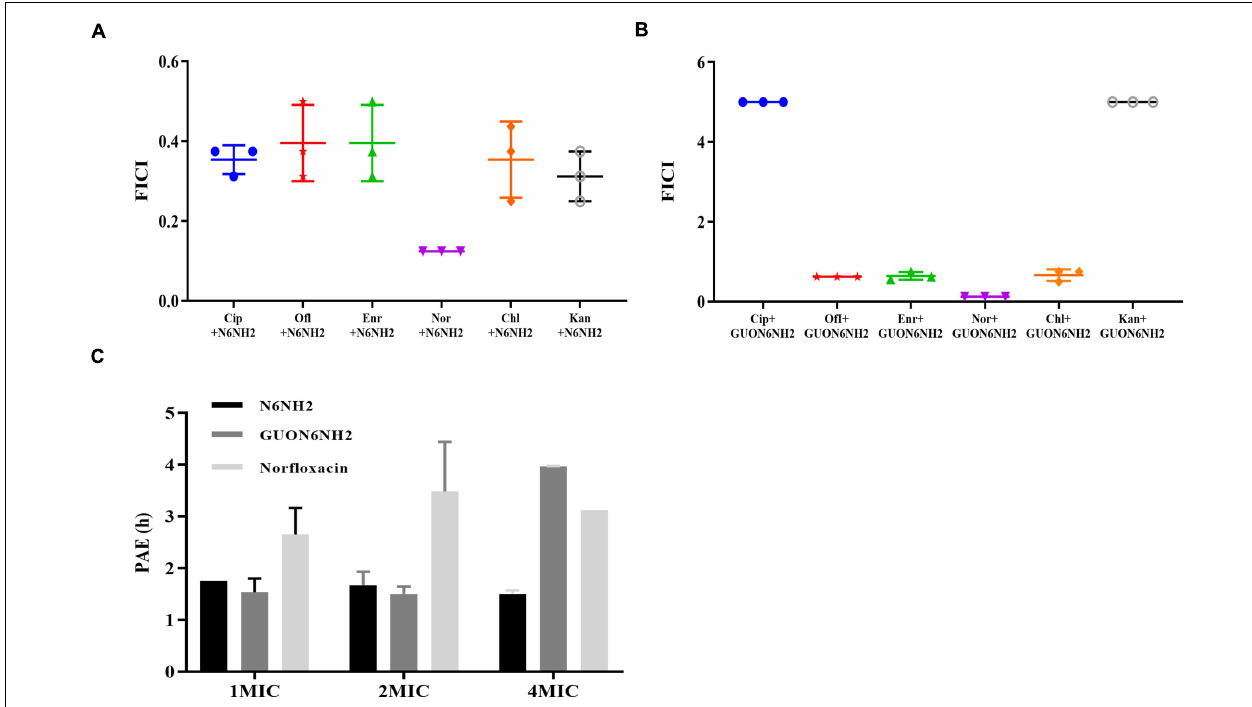
FIGURE 2 | In vitro efficacy of N6NH2 and GUON6NH2. (A,B) Combination of peptide N6NH2 (A) and GUON6NH2 (B) with antibiotics against E. tarda , ciprofloxacin (Cip), ofloxacin (Ofl), enrofloxacin (Enr), norfloxacin (Nor), chloramphenicol (Chl), and kanamycin (Kan), respectively. (C) PAEs of N6NH2, GUON6NH2, and norfloxacin against E. tarda . The results are given as the mean ± SEM ( n = 3).